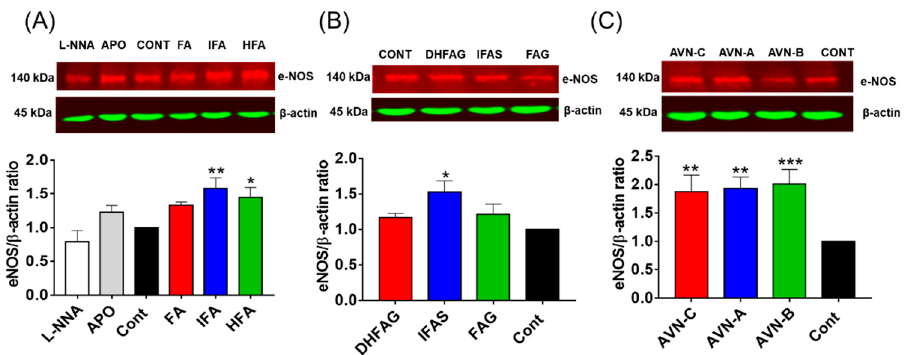
Figure 6. eNOS total protein levels measured in HUVEC pre-treated for 24 h with the un-conjugated oat phenolics ( A ), sulfate and glucuronide metabolites ( B ) and avenanthramides ( C ) at physiologically relevant concentration (1 µ M). Controls (CON) Ferulic acid (FA) isoferulic acid (IFA), dihydroferulic acid (DHFA), FA glucuronide (FAG), DHFA glucuronide (DHFAG), IFA sulfate (IFAS), avenanthramide A (AVN-A) avenanthramide B (AVN-B) avenanthramide C (AVN-C) were tested. Apocynin (APO, 100 µ M) and L-NG-Nitro-Arginine (L-NNA, 100 µ M) Apocynin (100 µ M) and L-NNA (100 µ M) were used as additional controls ( A ). Data with error bars represent the average ± SEM of 6 independent experiments and are expressed as phospho-Akt1/ total-Akt1 ratio. Protein levels were normalized against β -actin levels. * = p < 0.05, ** = p < 0.01, *** = p < 0.001 vs. control ( n = 6).